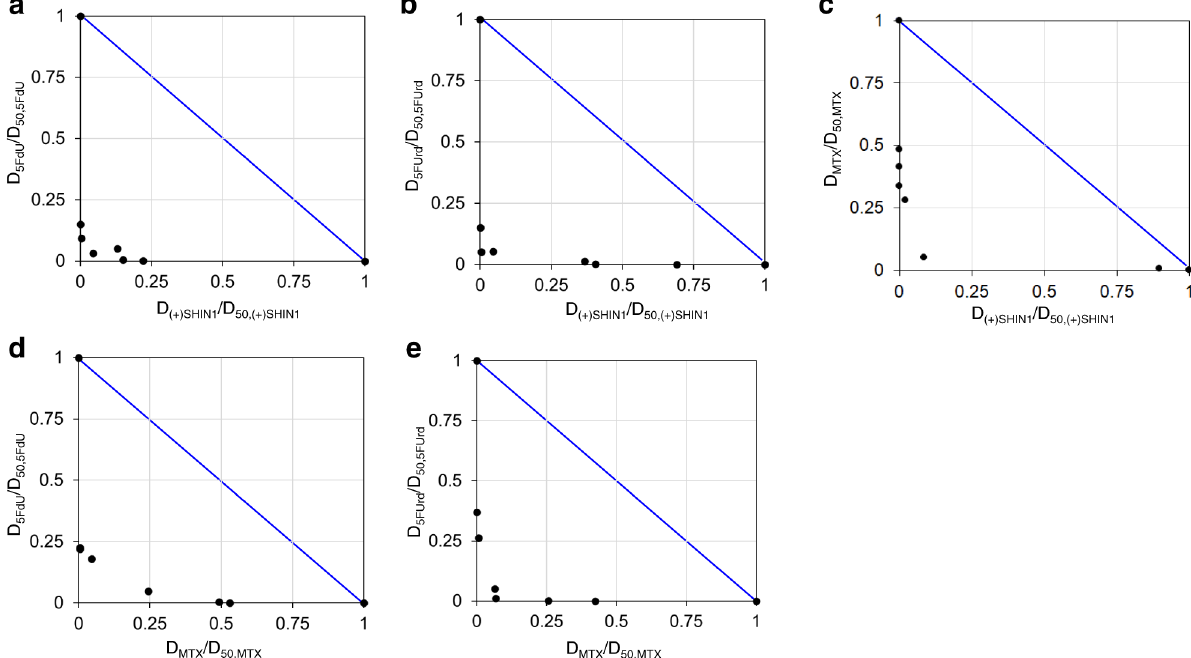
Fig. 7 Synergistic effect of each drug combination. a – e Isobolograms for each drug combination are shown. Synergistic effect of ( a ) ( + )-SHIN-1 and 5- FdU, ( b ) ( + )-SHIN-1 and 5-FUrd, ( c ) ( + )-SHIN-1 and MTX, ( d ) MTX and 5-FdU, and ( e ) MTX and 5-FUrd. D A and D B are the concentrations of compounds A and B, respectively, that achieve a 50% effective concentration under a drug combination. D 50, A and D 50, B denote the EC 50 values under monotherapy shown in Supplementary Tables S5 –